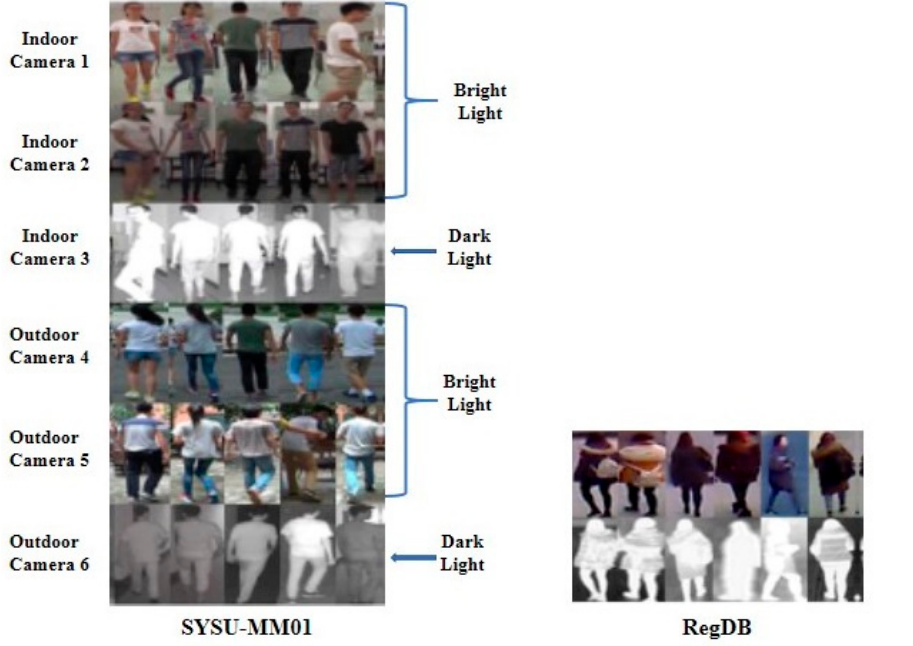
Figure 16. The left figure shows sample images from the SYSU-MM01 dataset and the right one shows sample images from the RegDB dataset.